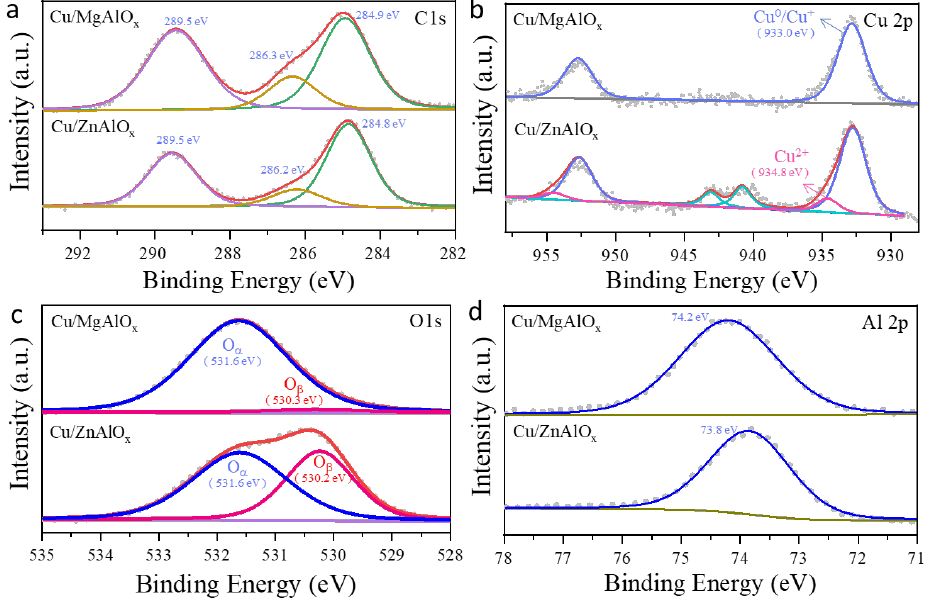
Figure 5. XPS spectra of different supported Cu catalysts: ( a ) C 1s; ( b ) O 1s; ( c ) Cu 2p; and ( d ) Al 2p.